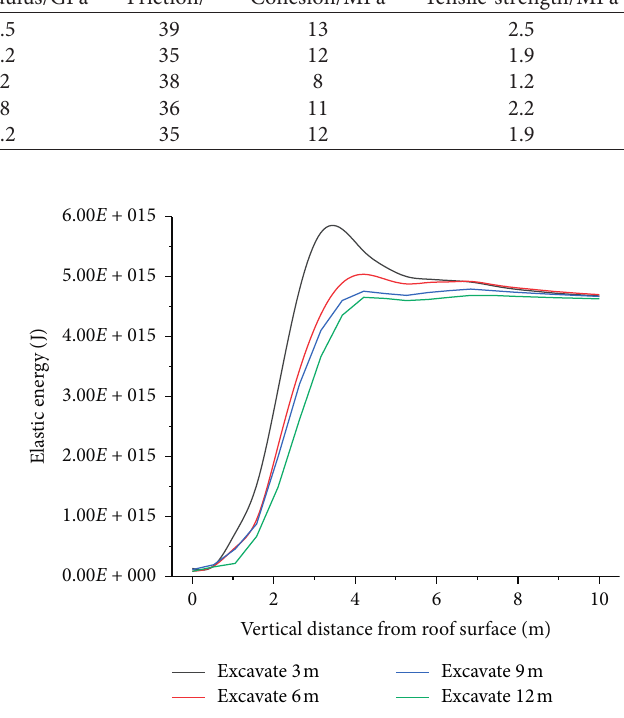
Figure 7: Elastic energy distribution under different excavation